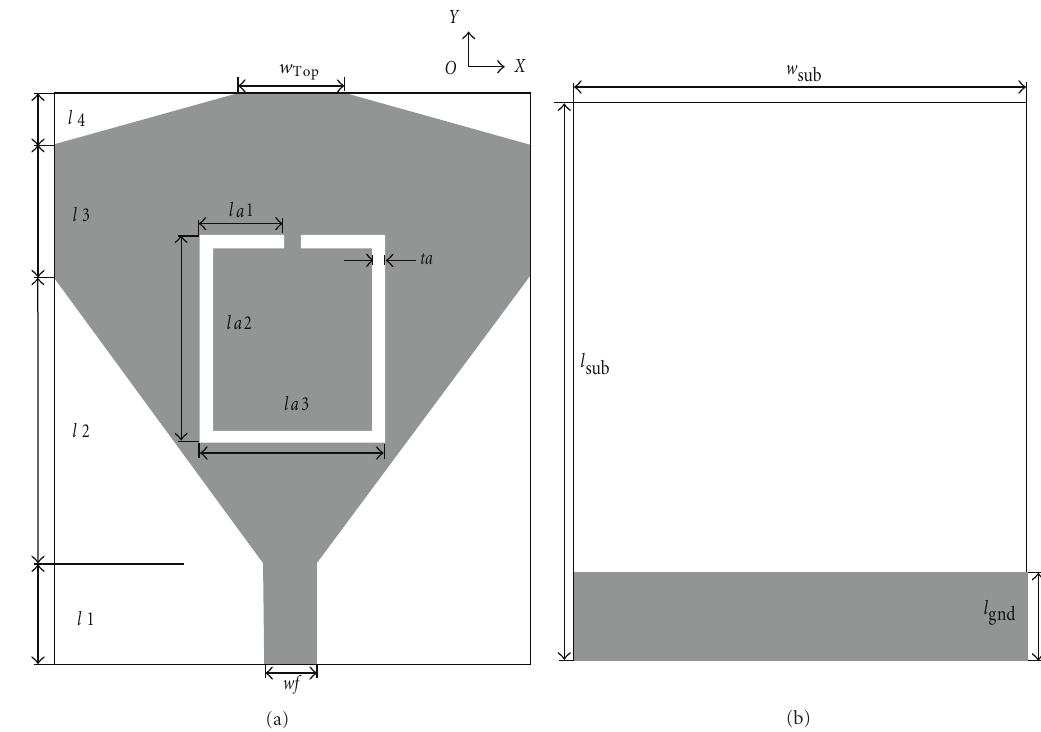
Figure 1: Geometry of single band-notched antenna. (a) Top view, (b) bottom view.